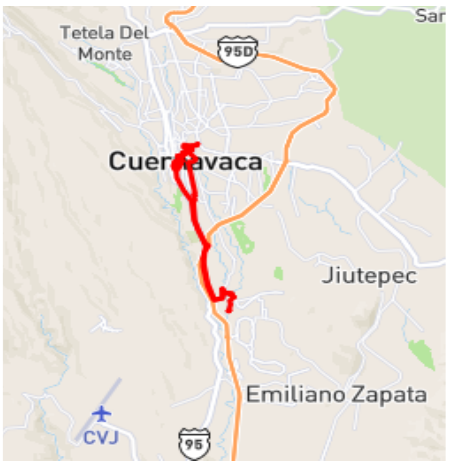
Figure 9 example of a tracking